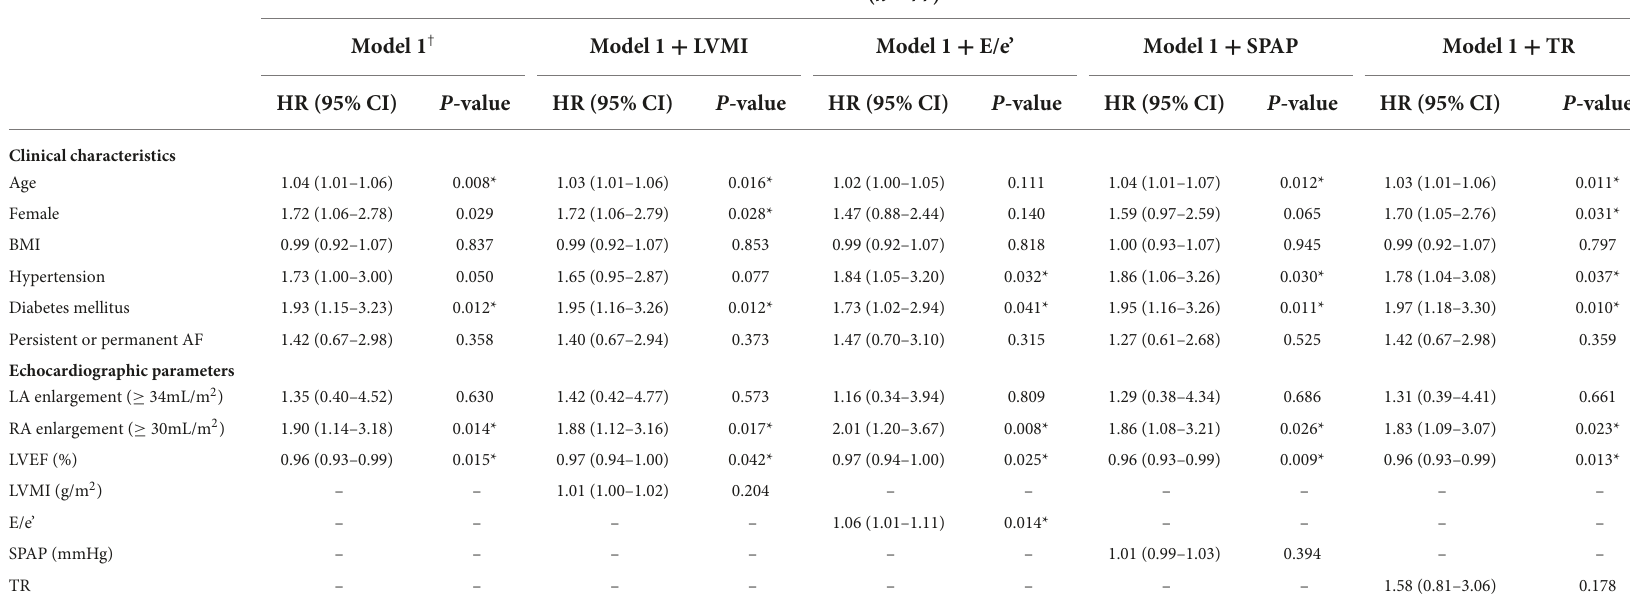
TABLE 3 Multivariate Cox proportional hazard analysis for primary composite outcomes of HHF, stroke, systemic embolism or all cause